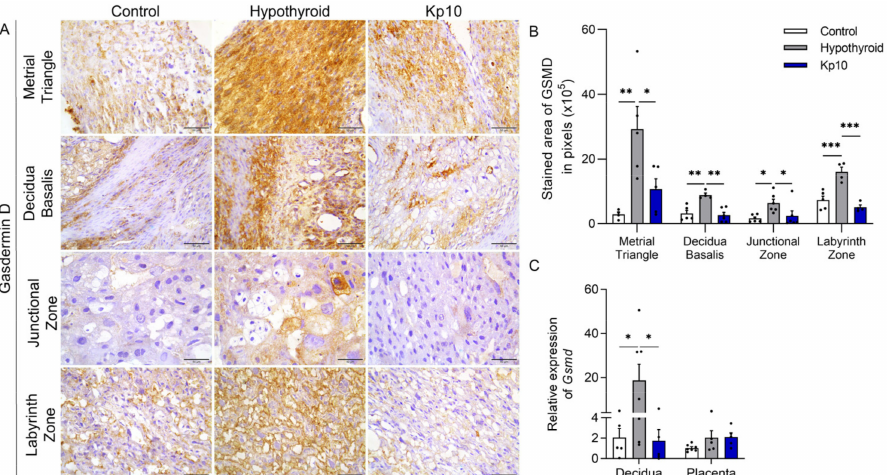
Figure 3. Expression of Gasdermin D at the maternal-fetal interfaces of control, hypothyroid, and kisspeptin-10 (Kp10)-treated rats. ( A ) Photomicrographs of the immunohistochemical expressions of Gasdermin D at the maternal-fetal interfaces (streptavidin-biotin-peroxidase; Harris hematoxylin; Bar = 50 µ m). ( B ) Immunostaining areas in pixels of Gasdermin D expression in the metrial triangle, basal decidua, junctional zone, and labyrinth zone (mean ± SEM; n = 8). ( C ) Relative gene expression of Gsmd in the decidua and placenta (mean ± SEM; n = 8). Significant differences were determined by post hoc ANOVA SNK, * p < 0.05, ** p < 0.01, *** p < 0.001. Kp10 = daily treatment with Kp10; DG = day of